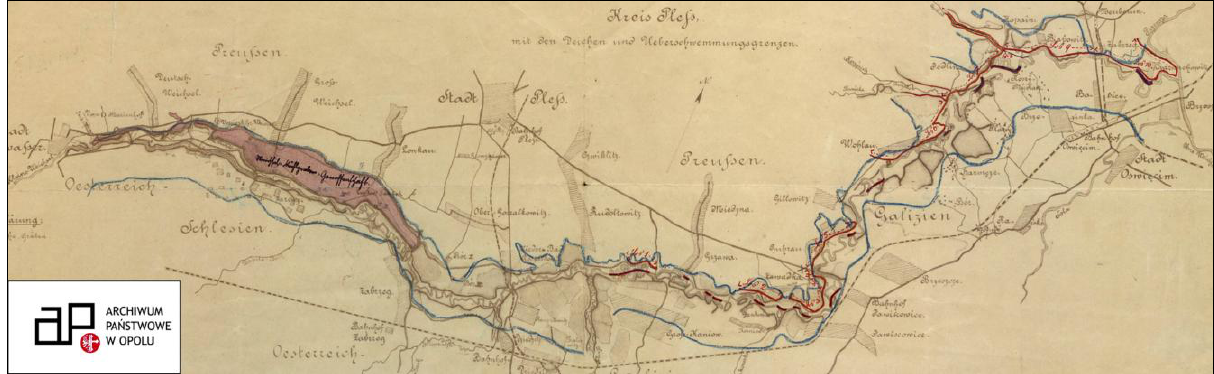
Fig. 1. Map of the River Little Vistula valley from the late 19 th century with the natural flooding zone marked (after Lageplan…, 1895, original scale: 1:75,000, State Archives in